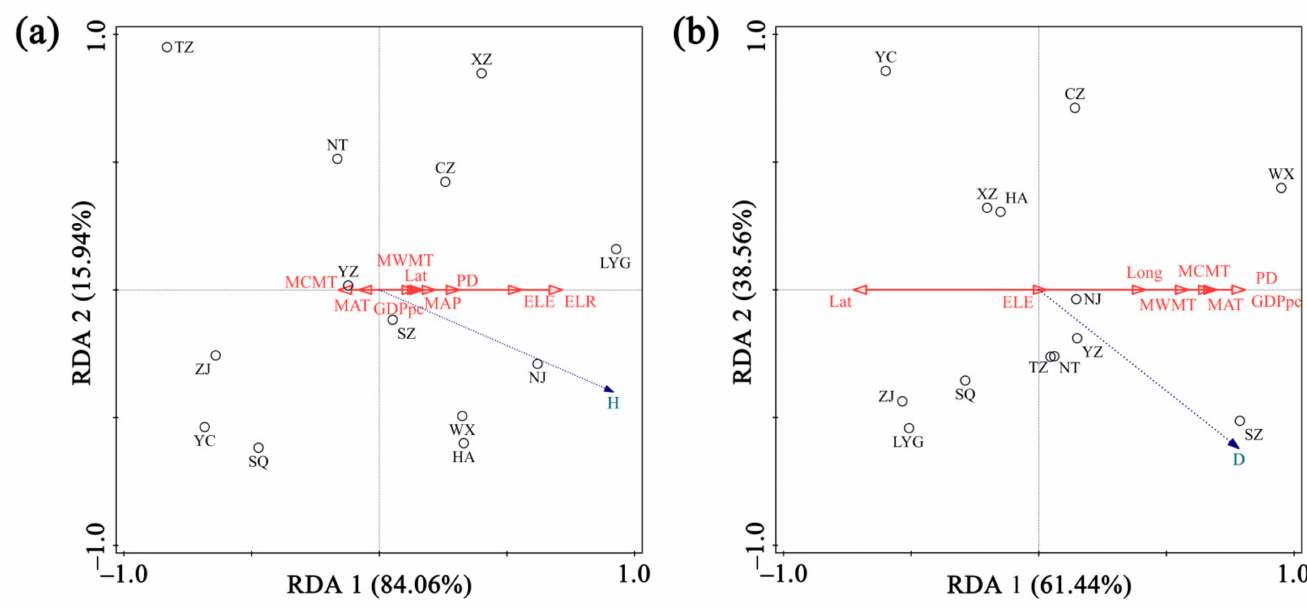
Figure 9. Redundancy analysis between species diversity ( a ), tree density ( b ), and environmental variables, respectively, in Jiangsu Province, eastern China. Blue dashed arrows represent different types of response variables. Red solid arrows represent different environmental factors mentioned in the text. Hollow circles represent the 13 studied cities in Jiangsu. Long: longitude, Lat: latitude, ELE: average elevation, ELR: elevation range shift, MAT: mean annual temperature, MAP: mean annual precipitation, MWMT: mean temperature of the warmest month, MCMT: mean temperature of the coldest month, GDPpc: GDP per capita, PD: population density. Refer to Table 1 for the meaning of the abbreviated